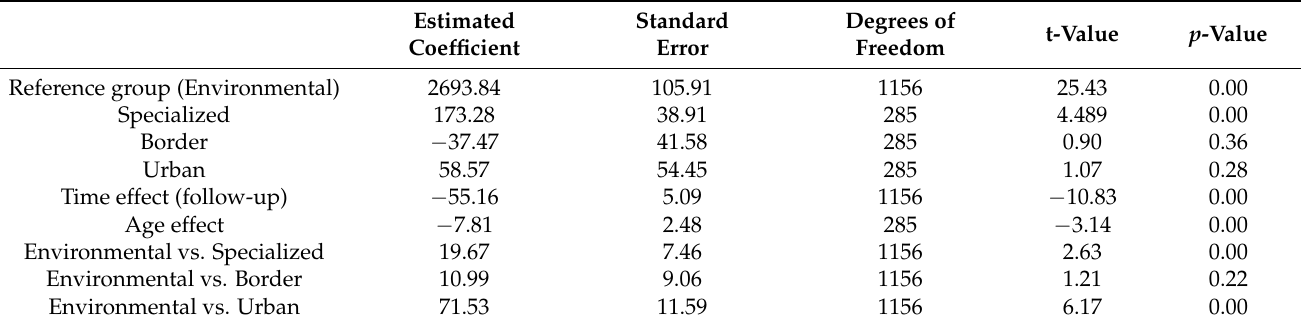
Figure 2. Behavior of the performance of police officers in different specialties in the 12-min run test throughout the follow-up. ( A ): Changes in distances covered over 5 years according to police specialties; ( B ): Distance traveled by police in relation to age; ( C ): Comparison of distances covered between police specialties at baseline (gray color indicates significant difference between the respective groups). Table 2. Statistical summary and model-estimated coefficients of the effect of group, time, and age on running performance.